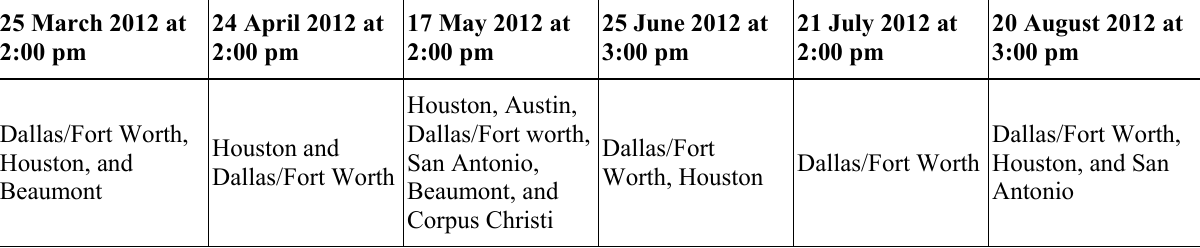
Table 1. Regions of Eastern Texas in which concentrations of O studied